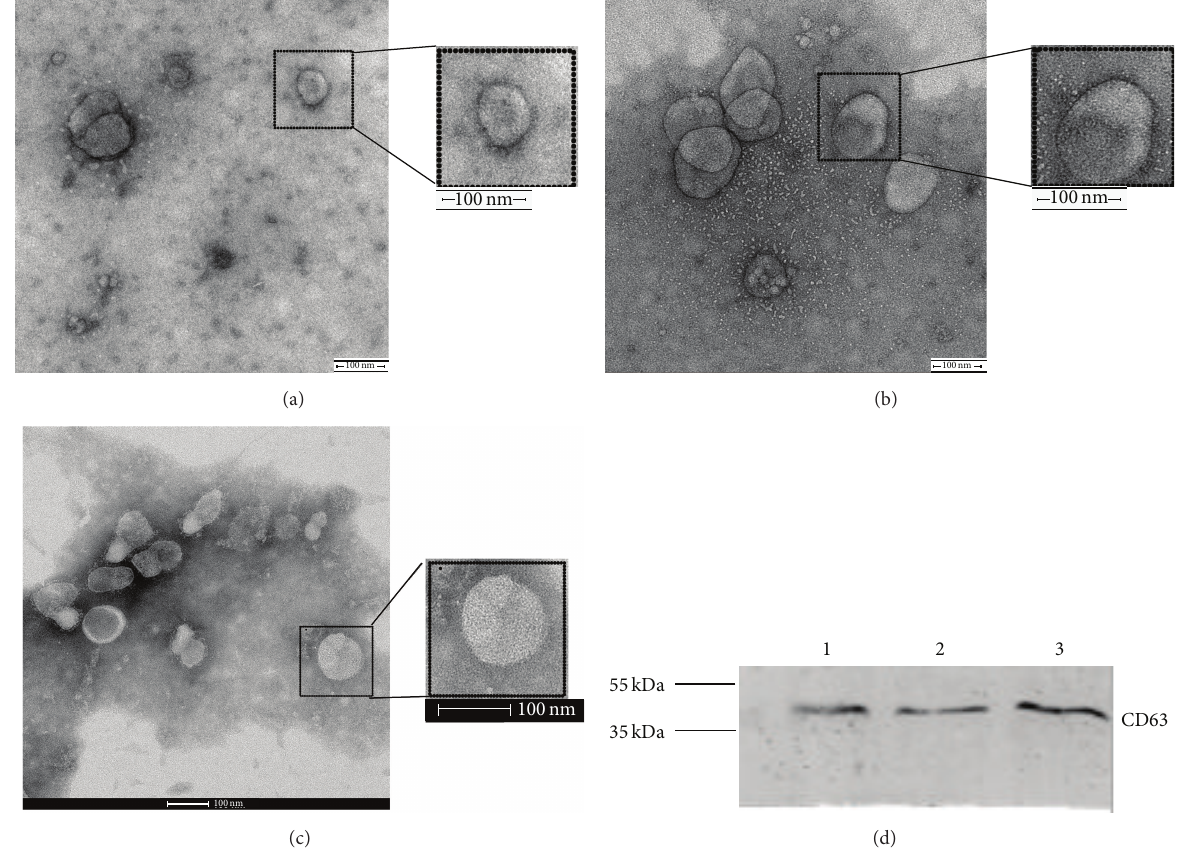
Figure 1: Characterization of EVs. (a) Transmission electron microscopy (TEM) of EVs from human proximal tubule cell supernatant. (b) TEM of EVs from mesangial cell supernatant. (c) TEM of urinary EVs. The scale bar represents 100 nm. (d) Western blot of EVs using the EV protein marker CD63. Lane 1: EVs from human proximal tubule cell supernatant; lane 2: EVs from mesangial cell supernatant; and lane 3: EVs from